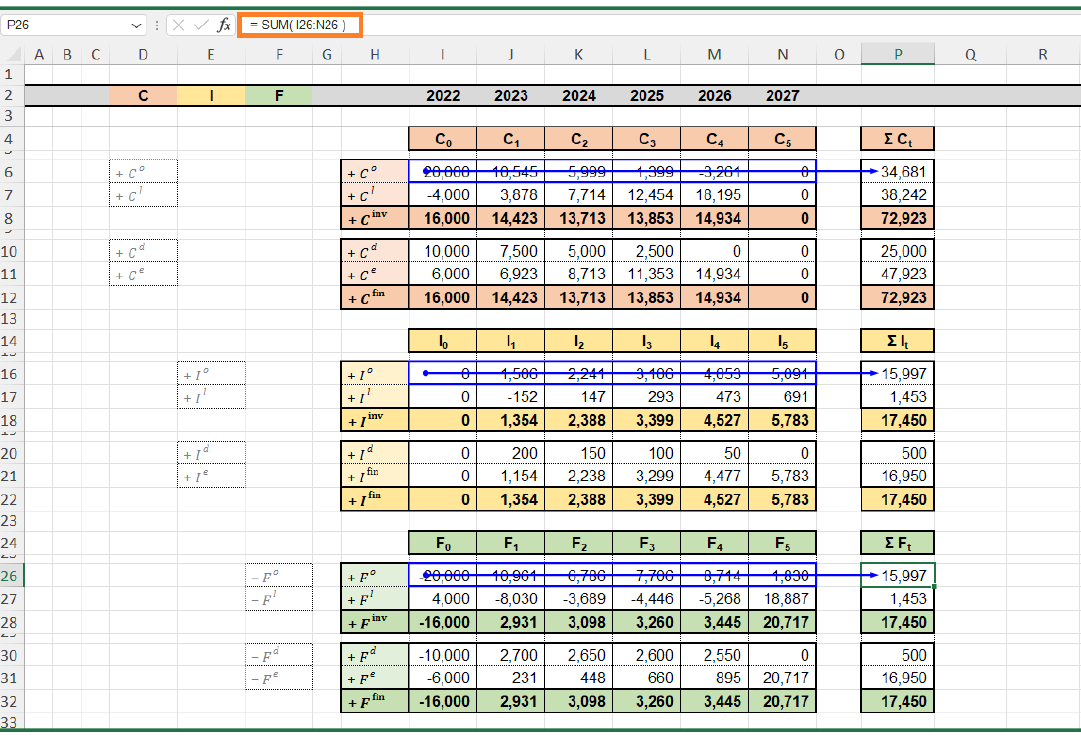
Figure 47. Column P contains the sums of the rows (“TransMatrix”